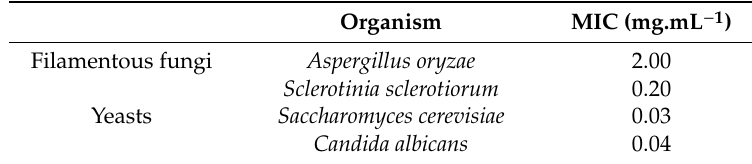
Table 4. Minimum inhibitory concentration (MIC) of disalt epipyrone A purified from Epicoccum nigrum ICMP 19,927 against di ff erent fungal